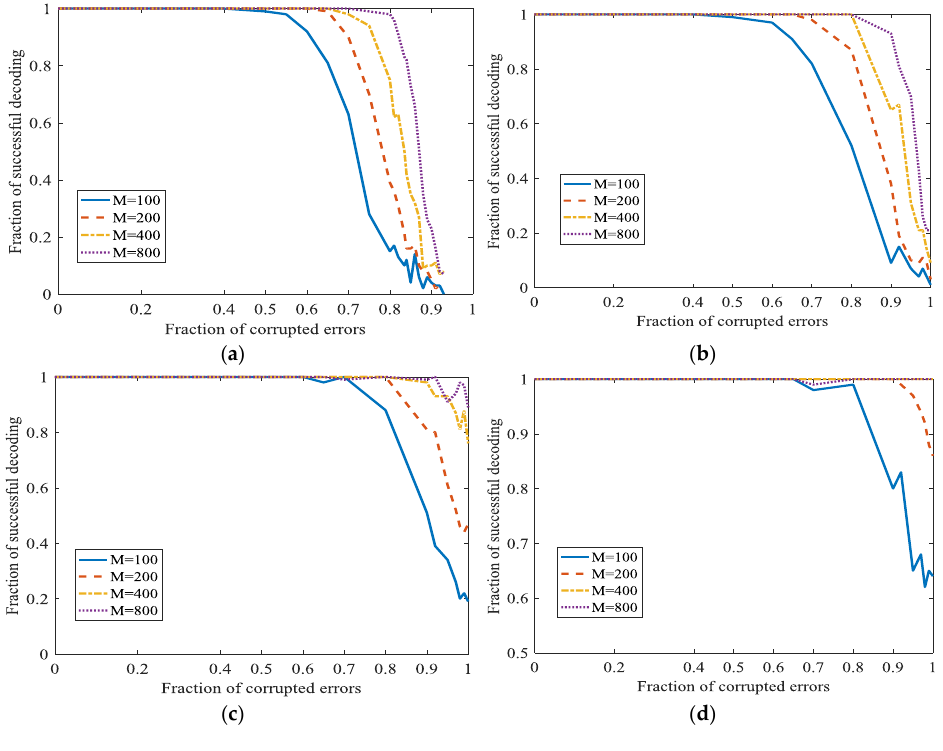
Figure 9. Error correction in L1 optimization when (cid:107) x 0 (cid:107) = 1 at different ϑ . ( a ) ϑ = 0; ( b ) ϑ = 0.1; . ( c ) ϑ = 0.2; ( d ) ϑ = 0.3. Sensors 2018 , 18 , x FOR PEER REVIEW